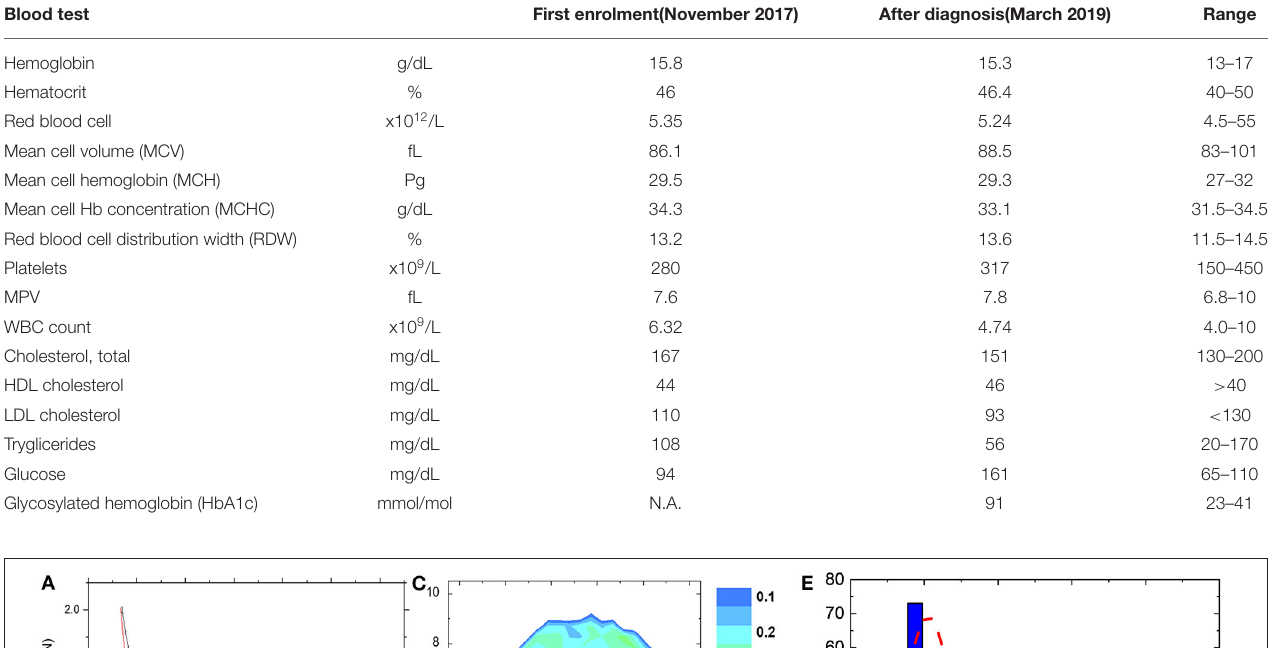
TABLE 2 | Subject’s Blood Tests at the first enrolment in the study and after receiving his T1DM diagnosis. Blood test